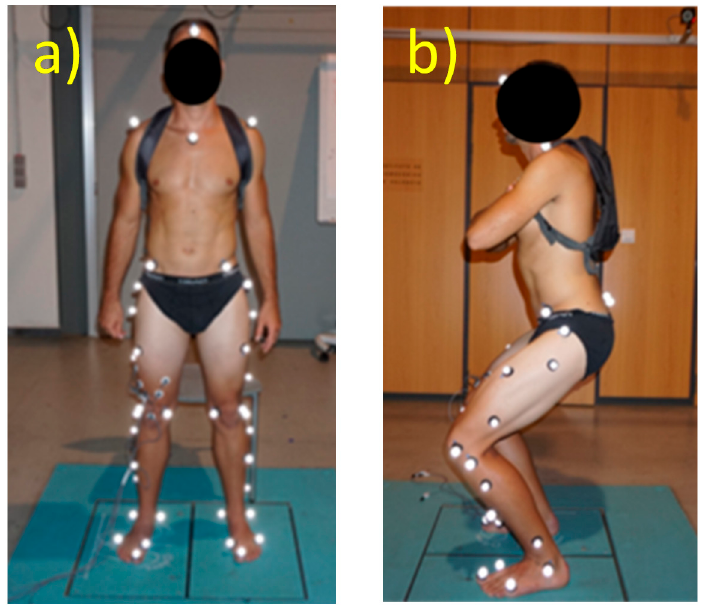
Figure 3. Experimental setup. ( a ) Subject in a standing upright position, as used for the static trial ( b ) Subject performing the squat.